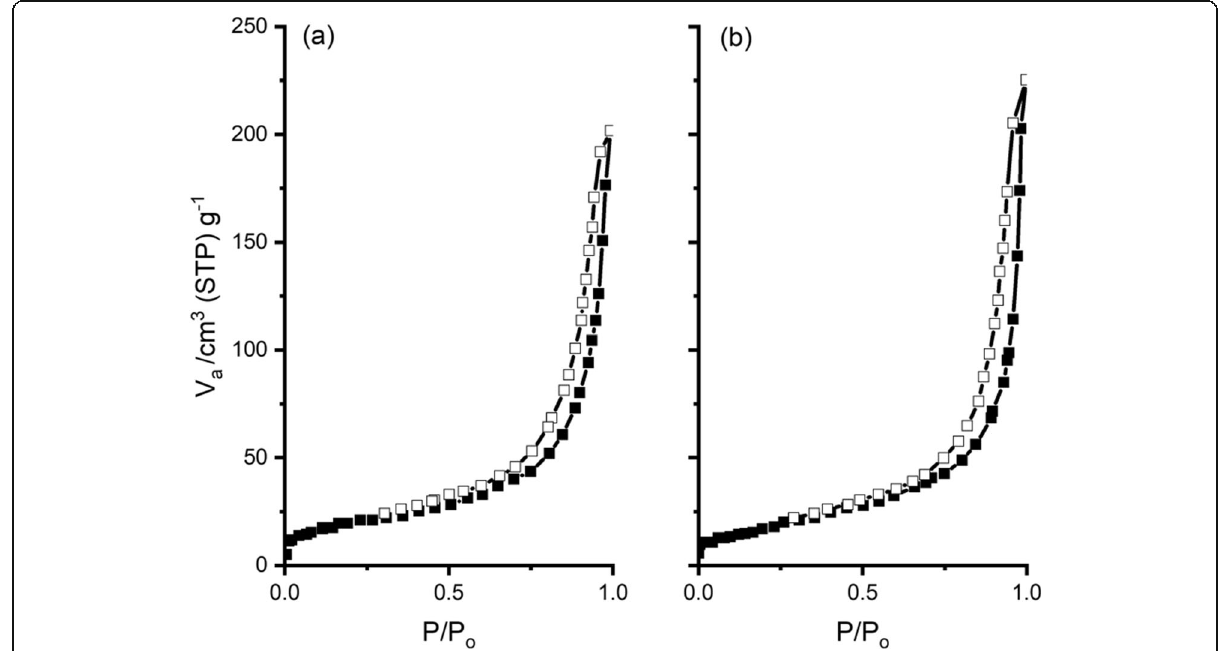
Fig. 3 Nitrogen adsorption/desorption BET isotherms of LDH22 ( a ) and CLDH22 ( b )